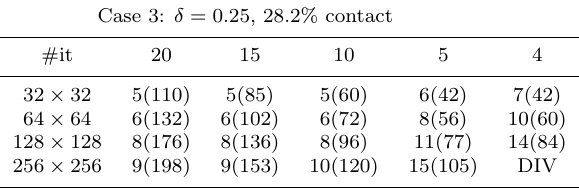
Case 3: the total number of active set iterations by inaccurate CG, with the numbers of work units in brackets. The second row is the number of CG iterations in each active set